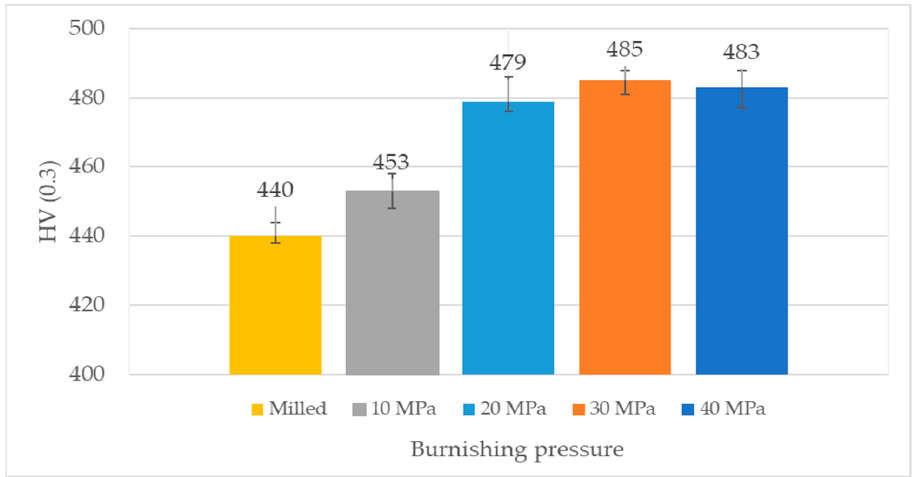
Figure 4. The results of microhardness measurements of discs.